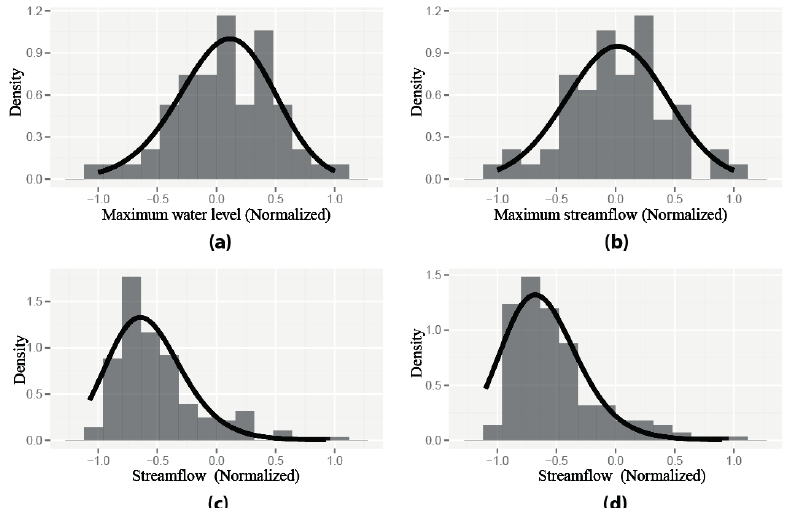
Fig. 1 Comparison of the empirical histograms and the POME-based PDFs: (a) S1, (b) S2, (c) S3 and (d)